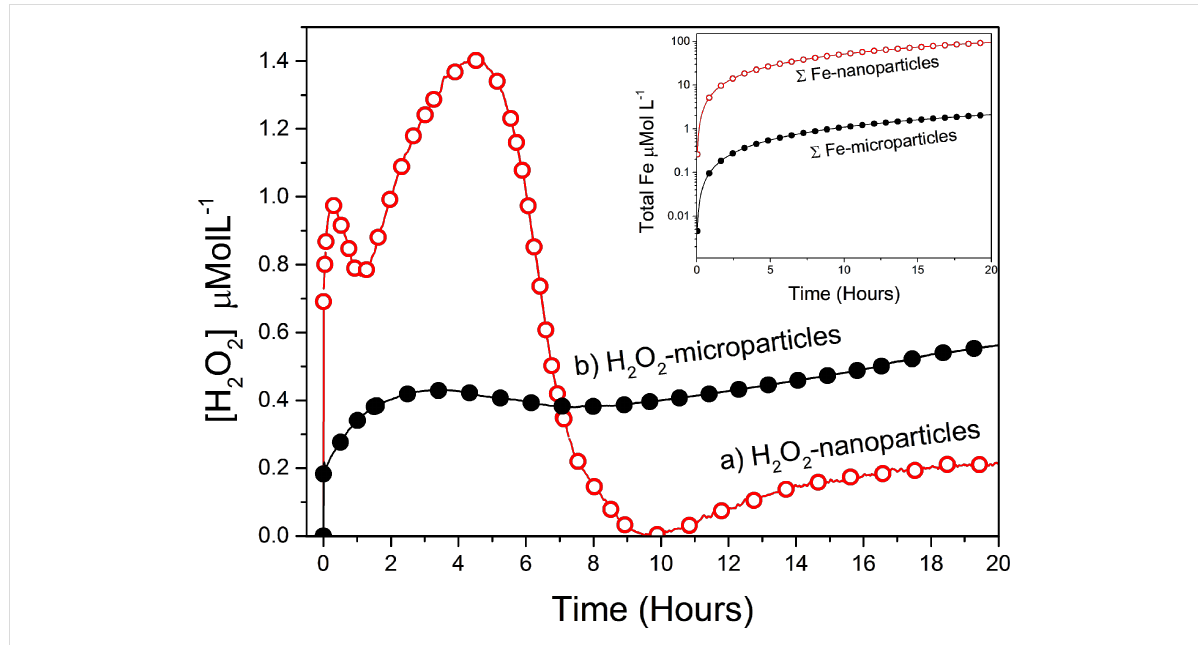
Figure 3: Plot of H 2 O 2 concentration over time for suspensions of: a) pyrite nanoparticles or b) pyrite microparticles, at loadings of 0.08 g/L. Inset: Plot of PHREEQC calculations of total iron [Fe 2+ + Fe 3+ ] delivered in each case, assuming cubes of 20 nm for nanoparticles and 1.4 µm for microparticles.